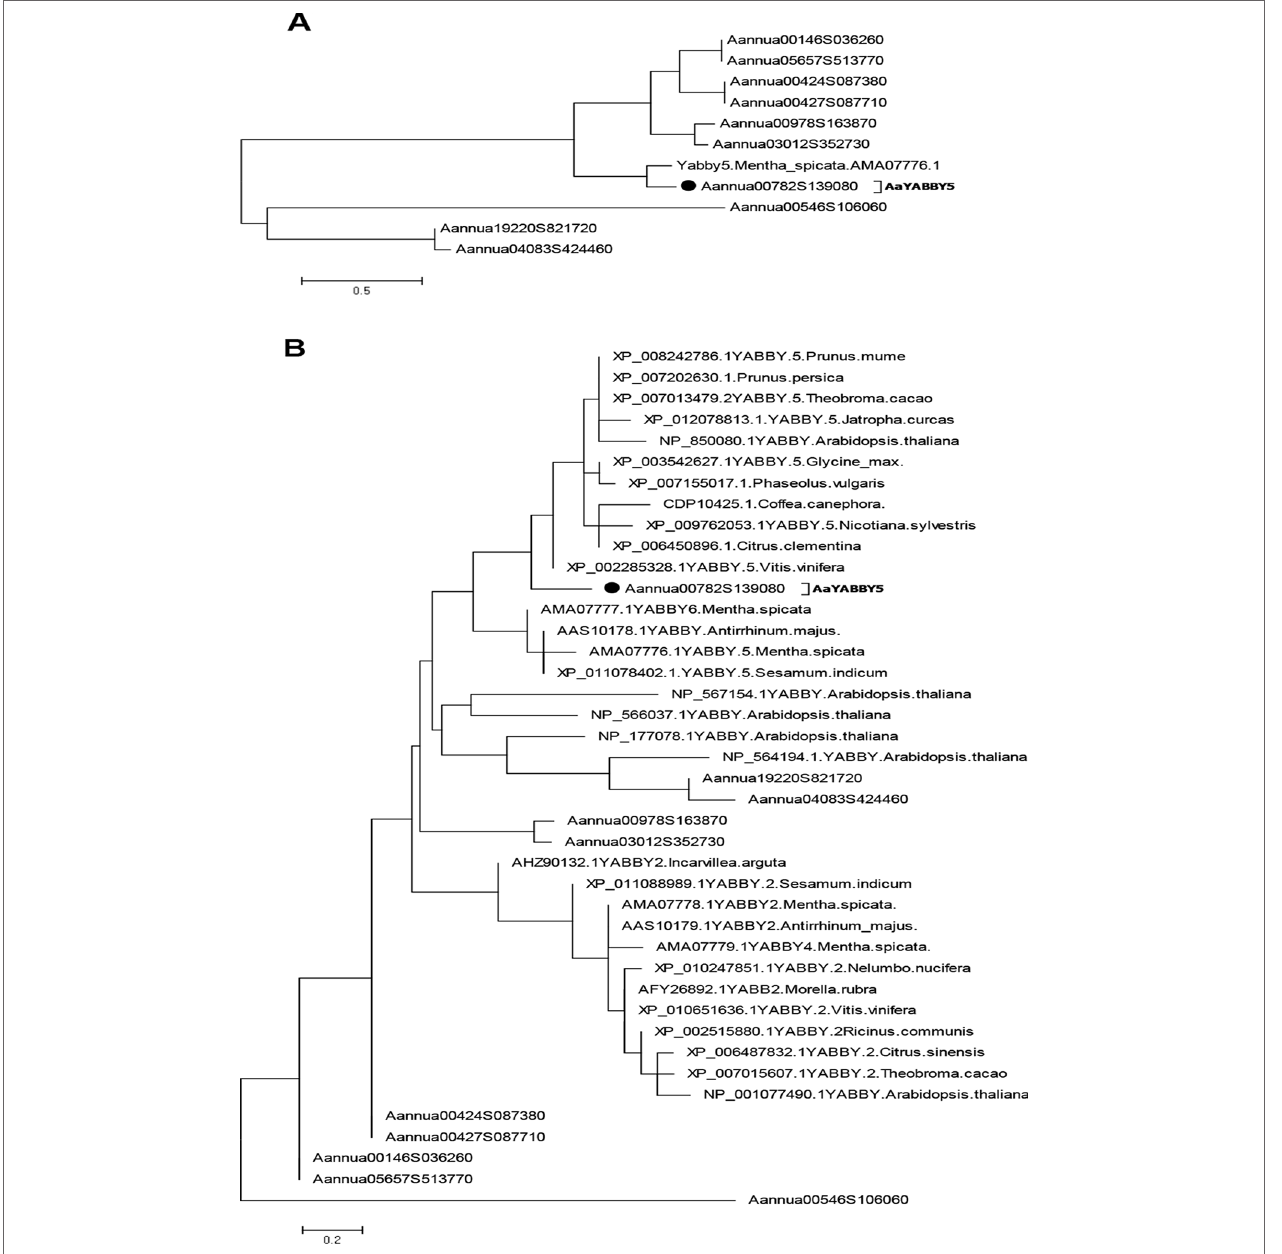
FIGURE 2 | Phylogenetic analysis. The phylogenetic tree was constructed by the maximum likelihood method using MEGA 6.06. Bootstrap analysis was performed using 500 replicates. (A) Phylogenetic relationship was found using protein sequences from Artemisia annua YABBYs and MsYABBY5 protein. (B) Phylogenetic analysis was performed using YABBY family proteins from A. annua , Mentha spicata , Arabidopsis thaliana , and various other plant species. AaYABBY5 clustered among YABBY5 members of other plants. The accession number of AaYABBY5 in GenBank is